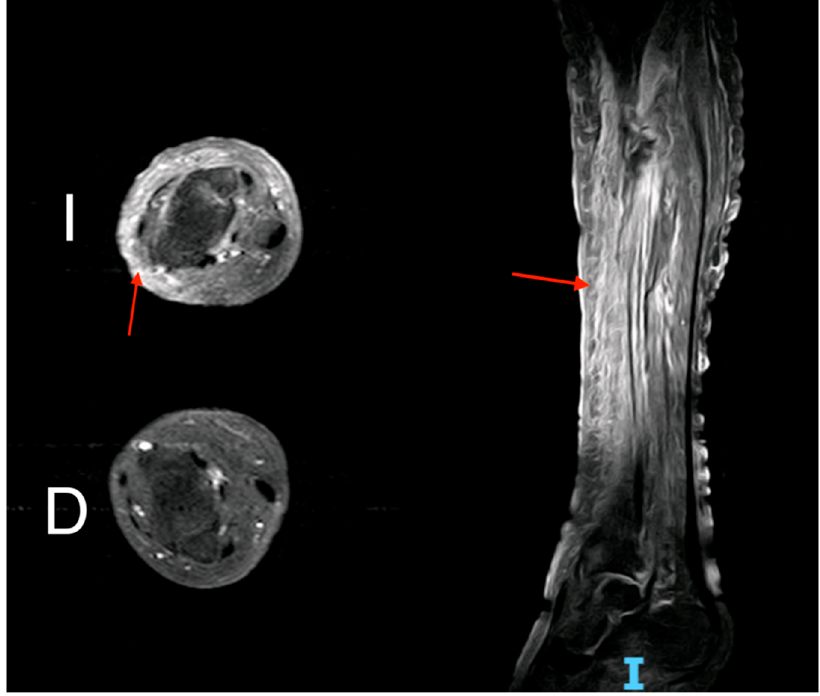
Figure 2. Magnetic resonance imaging of legs in axial ( left ) and sagittal ( right ) views. Arrows show the deep involvement of the infection with hyperintense image.